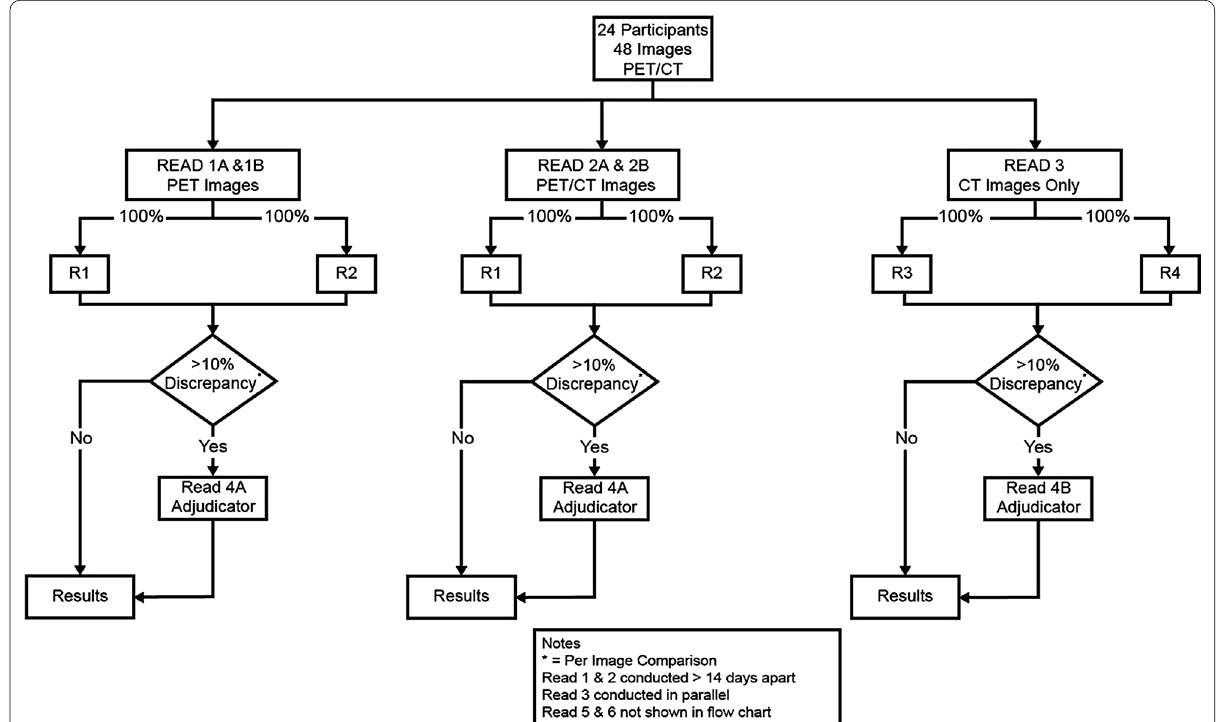
Fig. 2 Read design. Abbreviations: CT, computed tomography; PET, positron emission tomography; R,